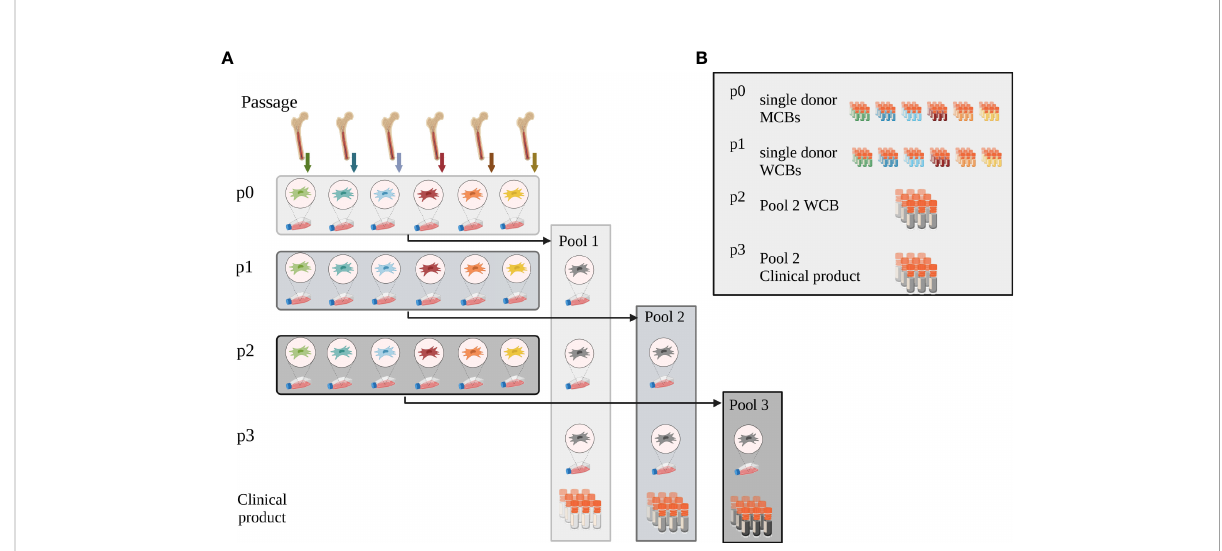
FIGURE 1 Pooling concept. (A) Pooling concept: hMSCs were isolated and expanded from bone marrow from six individual donors (passage p0). To initiate passage 1 expansion, single donor hMSCs were then thawed and either pooled at the onset of passage 1 (Pool 1) or expanded as single- donor hMSCs individually. These were then either pooled at the onset of passage 2 (Pool 2) or 3 (Pool 3), respectively. Pooled hMSCs at the end of passage 3 were cryopreserved, formulated as clinical product. (B) Master and Working Cell Bank concept: at the end of passage 0, single donor-derived hMSCs were cryopreserved as single donor MCBs. Single donor MSCs expanded in passage 1 were cryopreserved when harvested after passage 1 and served as WCBs. Pool 2 hMSCs, pooled at the onset of passage 2, were cryopreserved as working cell bank (WCB Pool 2) at the end of passage 2. Aliquots from this WCB were thawed and expanded one further passage to yield the potential clinical product end of passage 3. These cells were thawed and used for all experiments. Created with